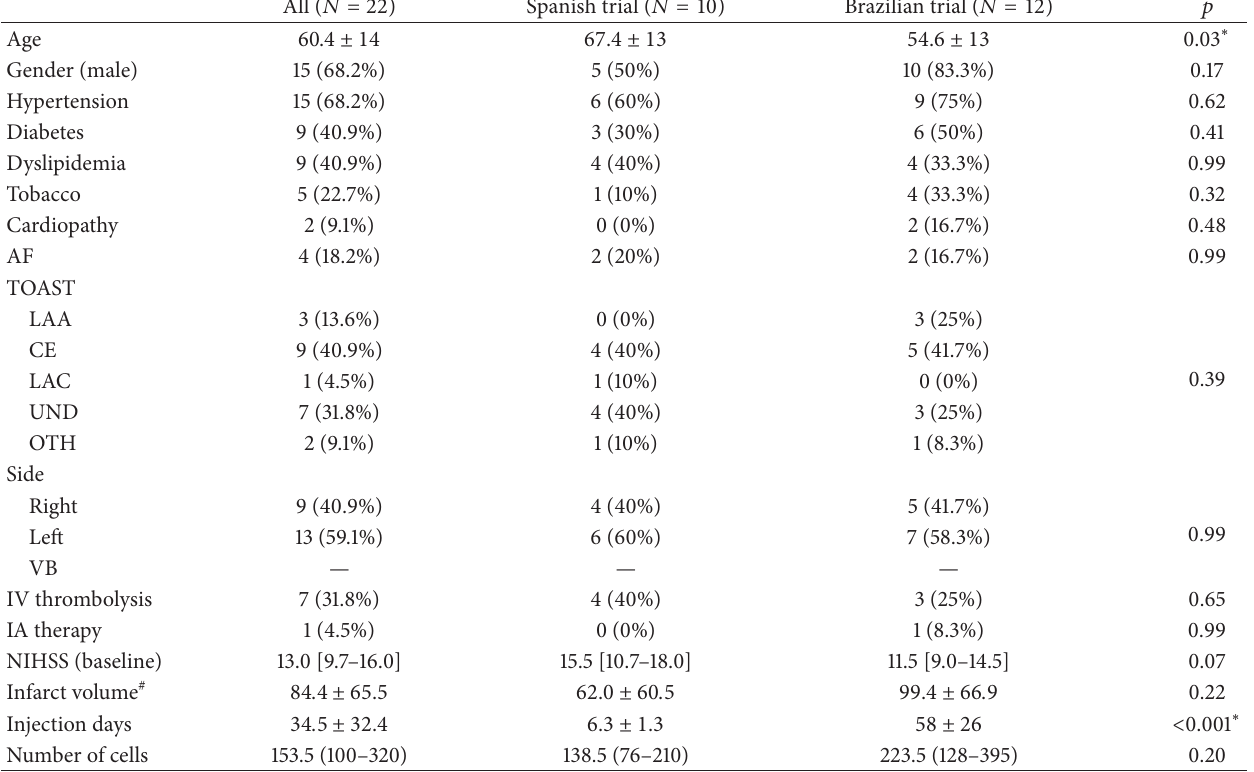
Table 1: Baseline characteristics of patient treated in both clinical trials.